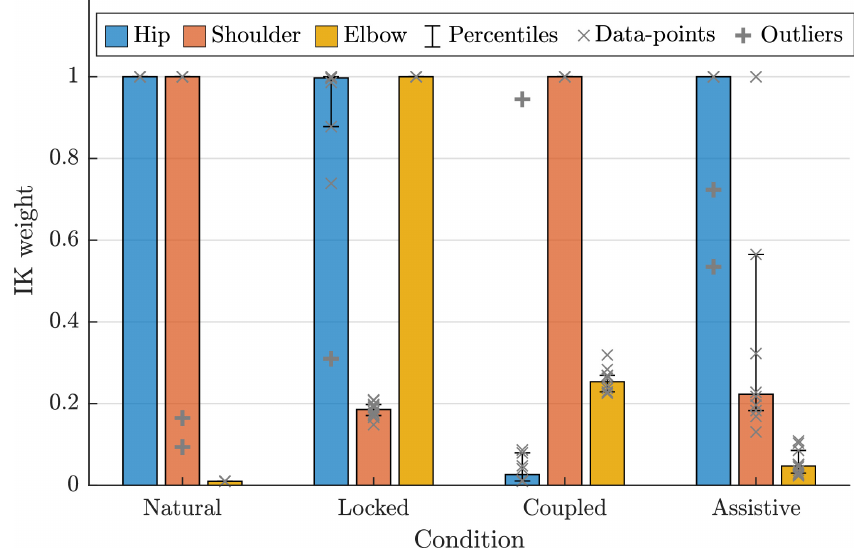
Fig 9. The estimated IK weights for the 10 subjects in the four different